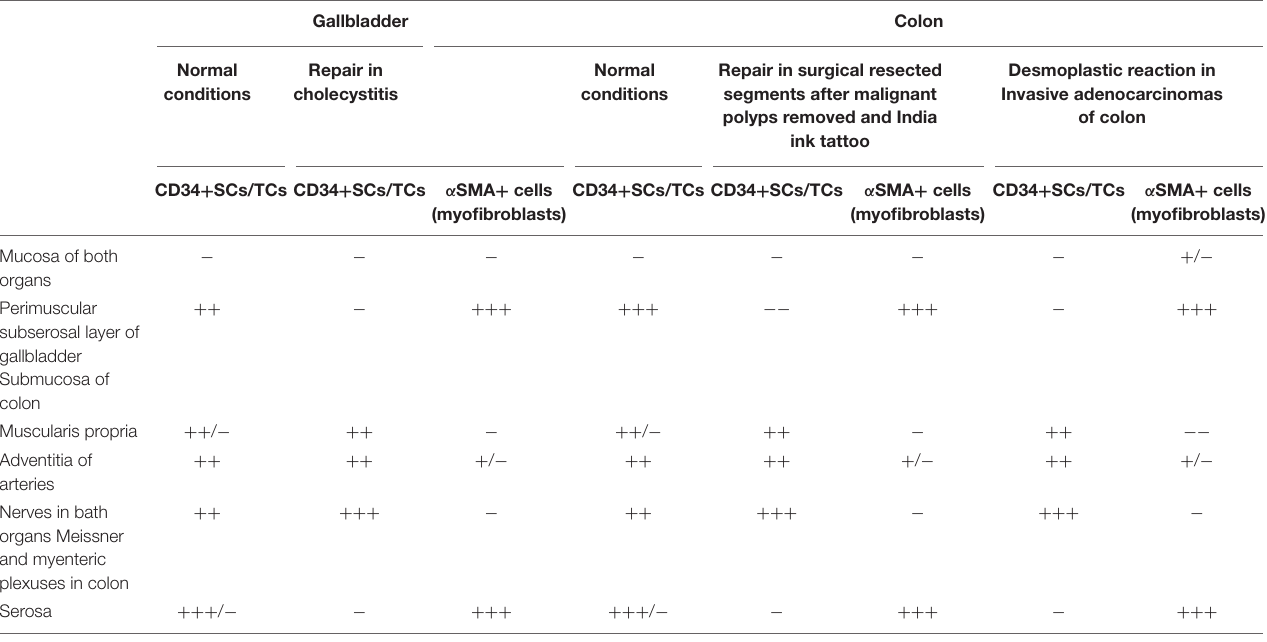
TABLE 1 | Presence/Absence and semiquantification of CD34 + SCs/TCs in normal conditions, and CD34 + SCs/TCs and α SMA + cells (myofibroblasts) during repair and tumoral stroma formation.